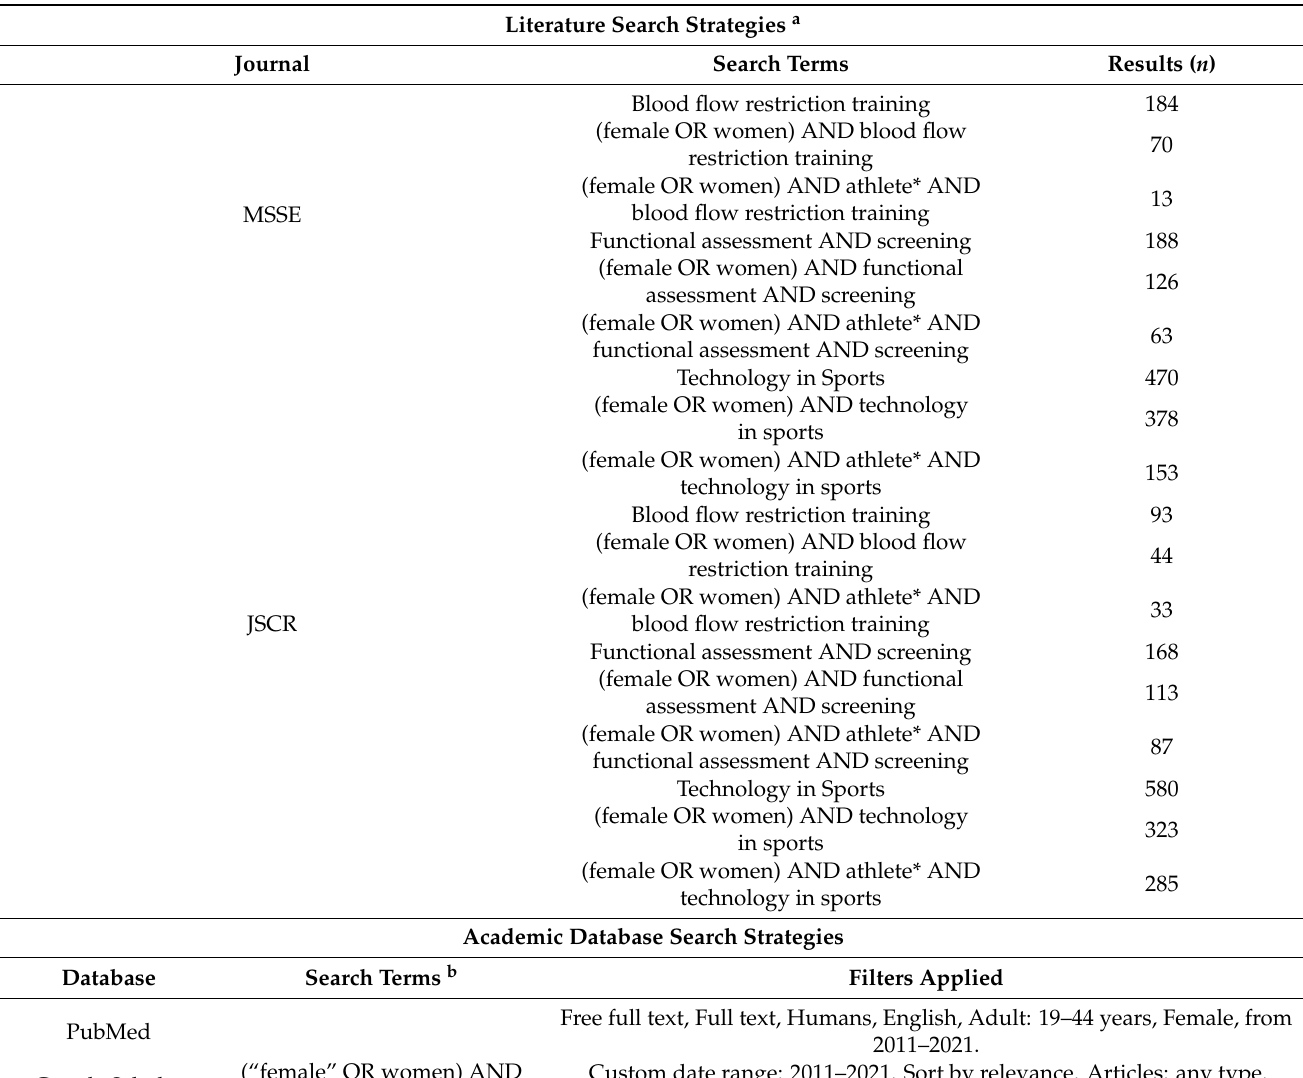
Table 1. Initial literature and database search